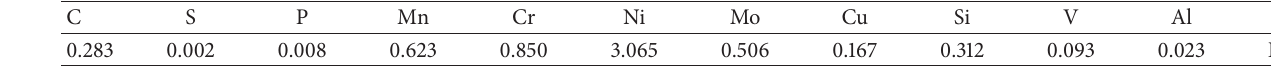
Table 1: Chemical composition (wt%) of the steel substrate.